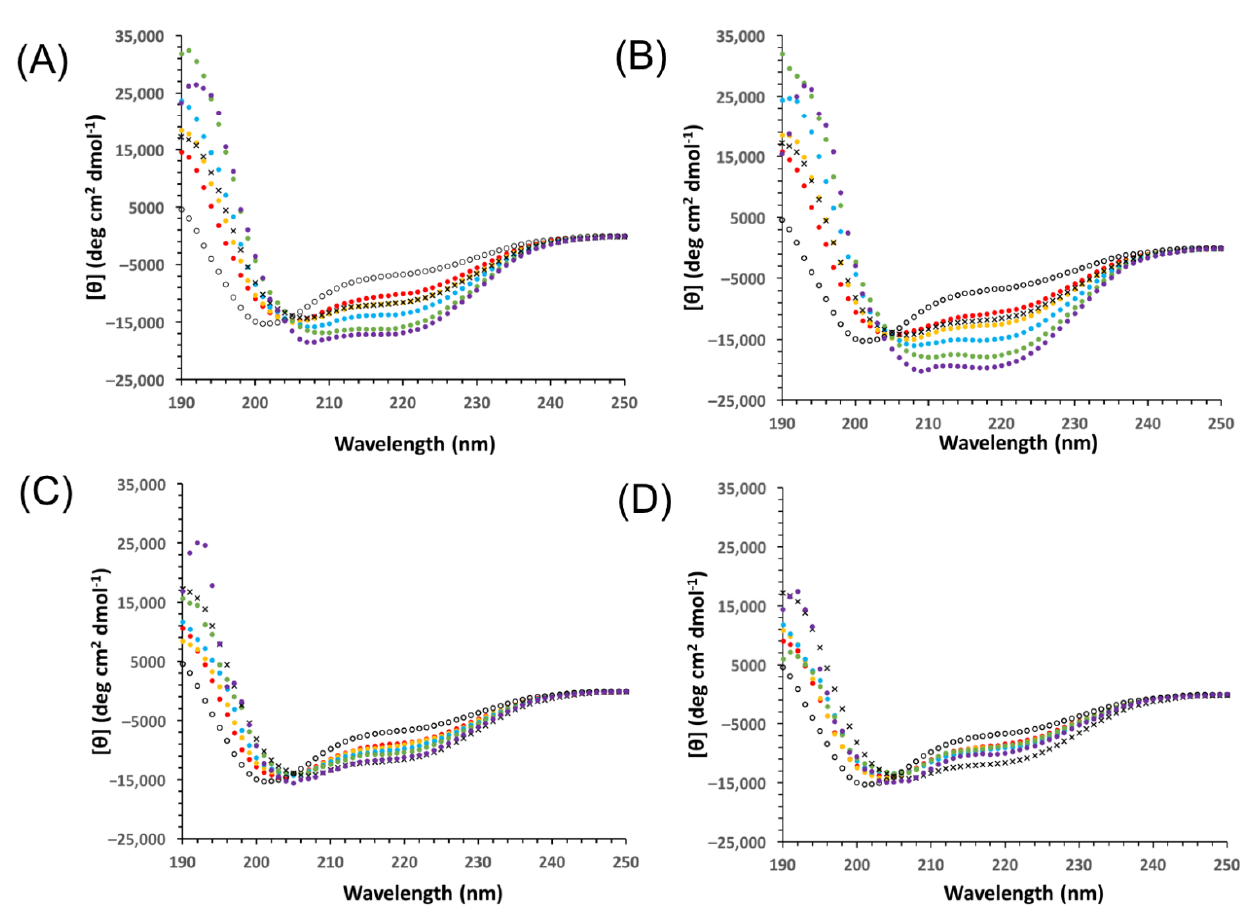
Figure 5. Yfh1 spectra in the presence of YSK 2 constructs. CD spectra of 10 μM Yfh1 at 1 °C in the presence of 5 (red), 7.5 (yellow), 10 (blue), 15 (green), and 20 μM (purple). ( A ) Yfh1 spectra in the presence of YSK 2 , ( B ) Yfh1 spectra in the presence of YSK 2 -K → R, ( C ) Yfh1 spectra in the presence of YSK 2 -SpaceK and ( D ) Yfh1 spectra in the presence of YSK 2 -Neutral. The panels also contain the spectra of 10 μM Yfh1 alone at 1 °C (black circles) and at 25 °C (black × symbols). Each spectrum is an average of three replicates. All samples were in 10 mM Tris, pH 7.4, buffer.